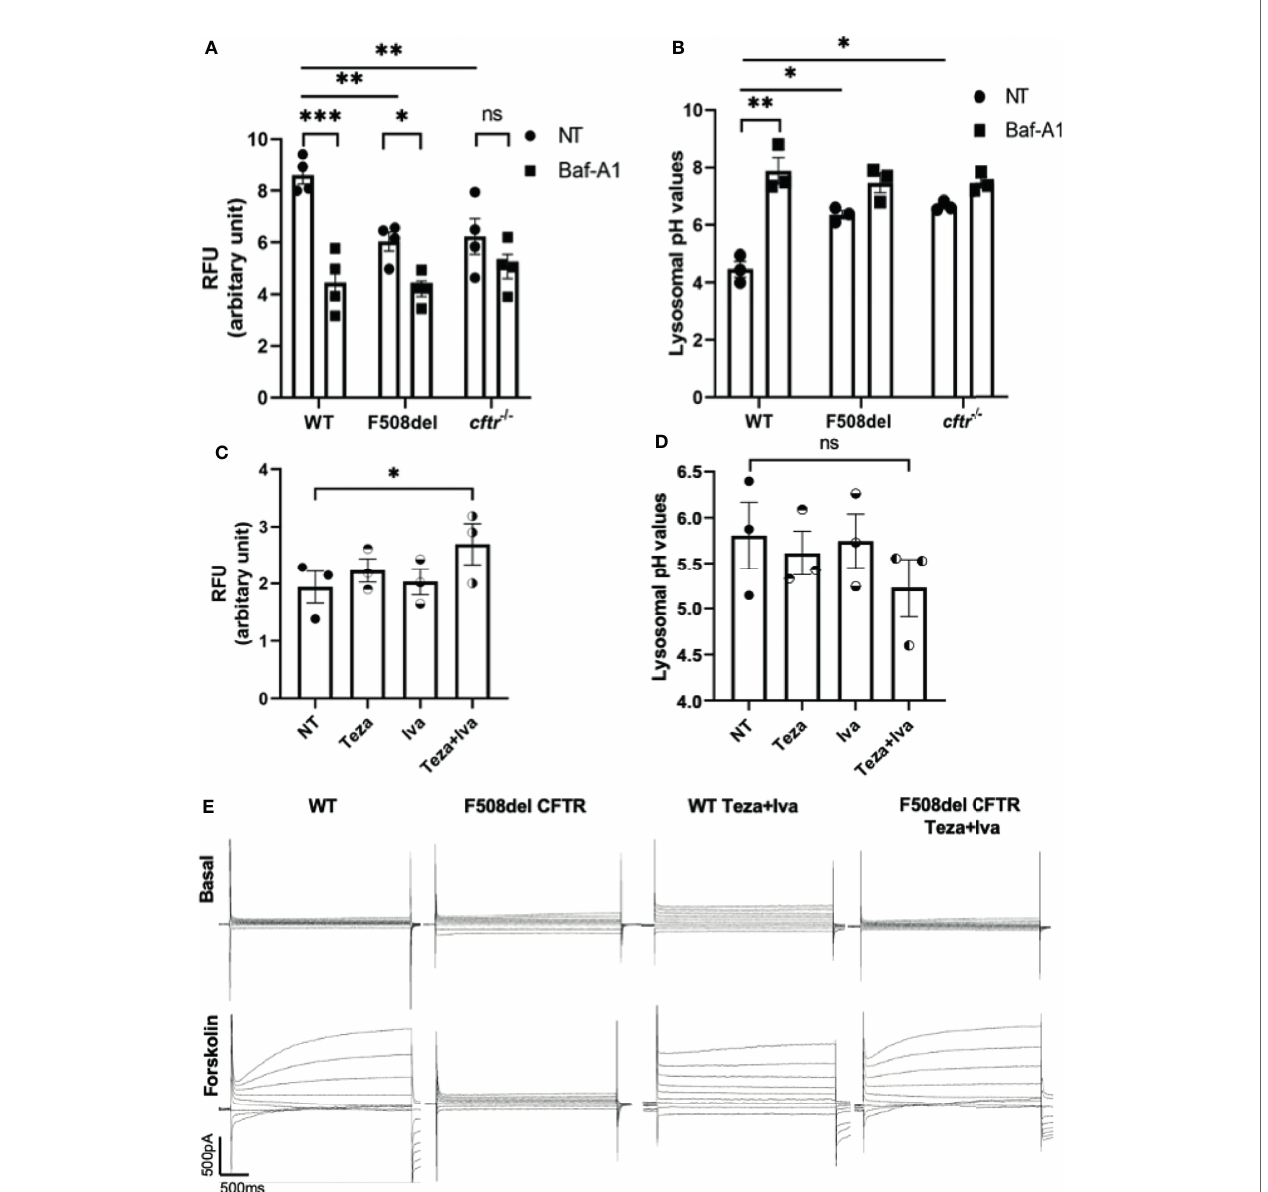
FIGURE 2 | CFTR is essential for maintaining autophago-lysosomal acidity in macrophages and responds to CFTR modulators. (A) Mean fl uorescence intensity (MFI) of LysoSensor Green DND-189 in wild-type (WT), F508del, and cftr − / − macrophages either non-infected (NT) or treated with Baf-A1. Data show MFI normalized to the number of cells. Data represent mean ± SEM (n = 4 biological replicates). Statistical analysis was performed using two-way ANOVA; *, p ≤ 0.05; **, p ≤ 0.01; ***, p ≤ 0.001; ns, non-signi fi cant. (B) Corresponding lysosomal pH values in WT, F508del, and cftr − / − macrophages stained with LysoSensor Green DND-189. Data represent MFI normalized to number of cells and plotted to the pH calibration curve. Data represent mean ± SEM (n = 3 biological replicates). Statistical analysis was performed using two-way ANOVA; *, p ≤ 0.05; **, p ≤ 0.01. (C) MFI of LysoSensor Green DND-189 in F508del macrophages treated with 10 µM of Teza, 5 µM of Iva, or both for 24 h. Data represent mean ± SEM (n = 3 biological replicates). Statistical analysis was done using one-way ANOVA; *, p ≤ 0.05. (D) Corresponding lysosomal pH values in F508del macrophages NT or treated with the indicated CFTR modulators for 24 h. Data represent mean ± SEM (n = 3 biological replicates). Statistical analysis was performed using one-way ANOVA; ns, non-signi fi cant. (E) WT or F508del CFTR macrophages were seeded in coverslips, and F508del macrophages were treated with 10 m M of Teza and 5 m M of Iva for 24 h. Representative current traces for CFTR chloride channel conductance in WT and F508del macrophages are shown as basal state and after the addition of a cocktail (shown as forskolin) containing 1 m M of forskolin, 10 m M of cAMP, 100 m M of IBMX, and 2 mM of ATP. Step protocol consisted of 400-ms voltage from − 80 to +80mV from a holding potential of − 40mV. The traces show the basal and activated CFTR current in WT, F508del CFTR, WT Teza+Iva, and F508del CFTR Teza+ Iva macrophages (n = 3 biological